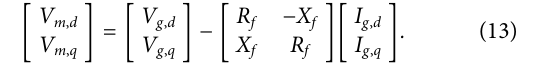
Frontiers in Energy Research |